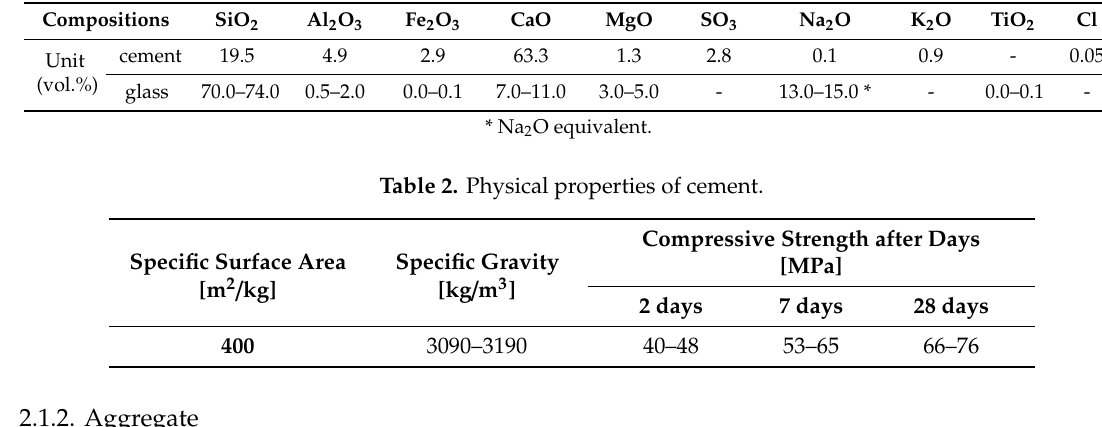
Table 1. Chemical composition of cement and glass cullet [54].